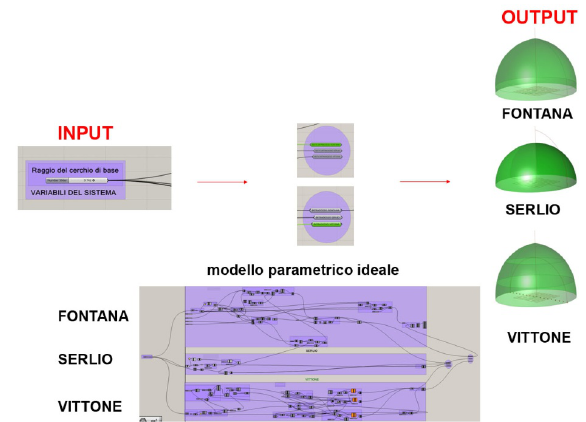
Figure 9. construction of parametric models based on treaties Domes parametric models based on treaties rules by Fontana, Serlio e Vittone.